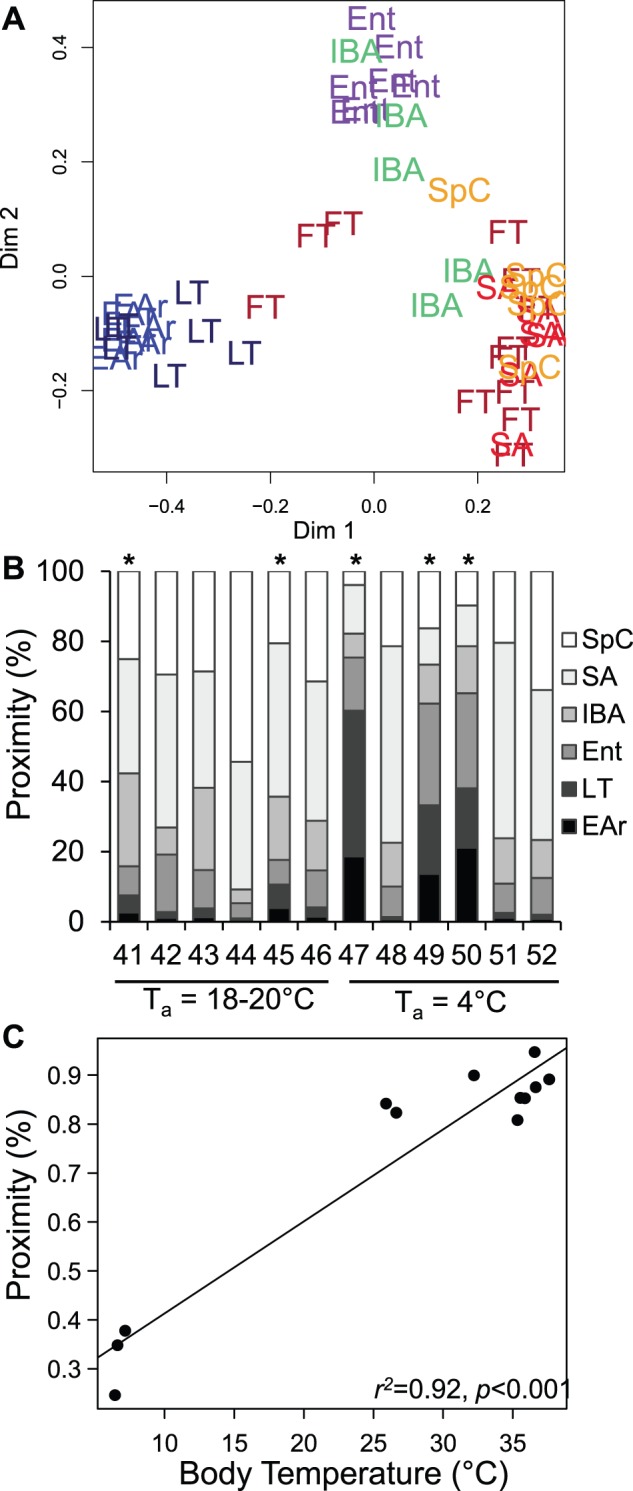
The fall proteome tracks body temperature.Fall transition individuals were held in warm (Ta = 18–20°C, #41–46) or cold rooms (Ta = 4°C, #47–52). (A) Unsupervised classification of all states using the most important predictors determined in Fig. 3A maintains the segregation of states by Tb. The mixed physiology of Fall animals can test the effect of Tb. (B) Unsupervised classification quantified proximity of FT individuals based on the defined groups as training data. In all but three individuals, more than 50% of the FT proteome was similar to summer or spring euthermic ground squirrels (x-axis: animal ID). The three exceptions were cold torpid (* denotes torpid), and instead had proteomes more proximate to LT/EAr. The absence of a similar pattern in the two warm-housed but torpid individuals (Tb = 18–21°C), supports the hypothesis that the LT/EAr proteome is defined by Tb, and not torpor per se. (C) Proximity to the euthermic groups (SA+SpC+IBA) correlates significantly with Tb.